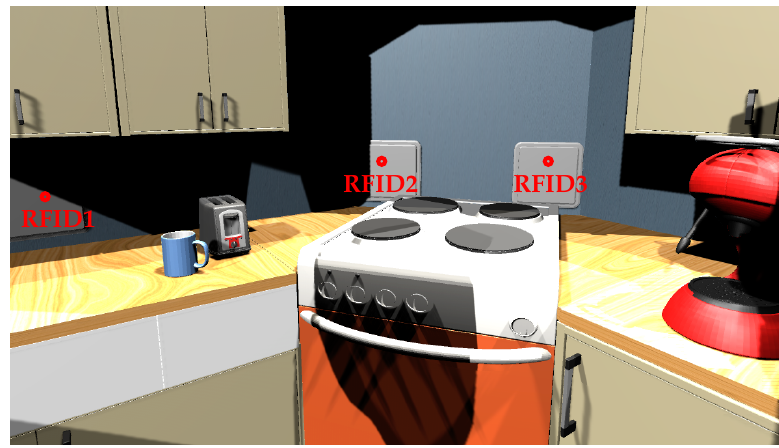
Figure 14. Screenshot of RFID antennas, front view.